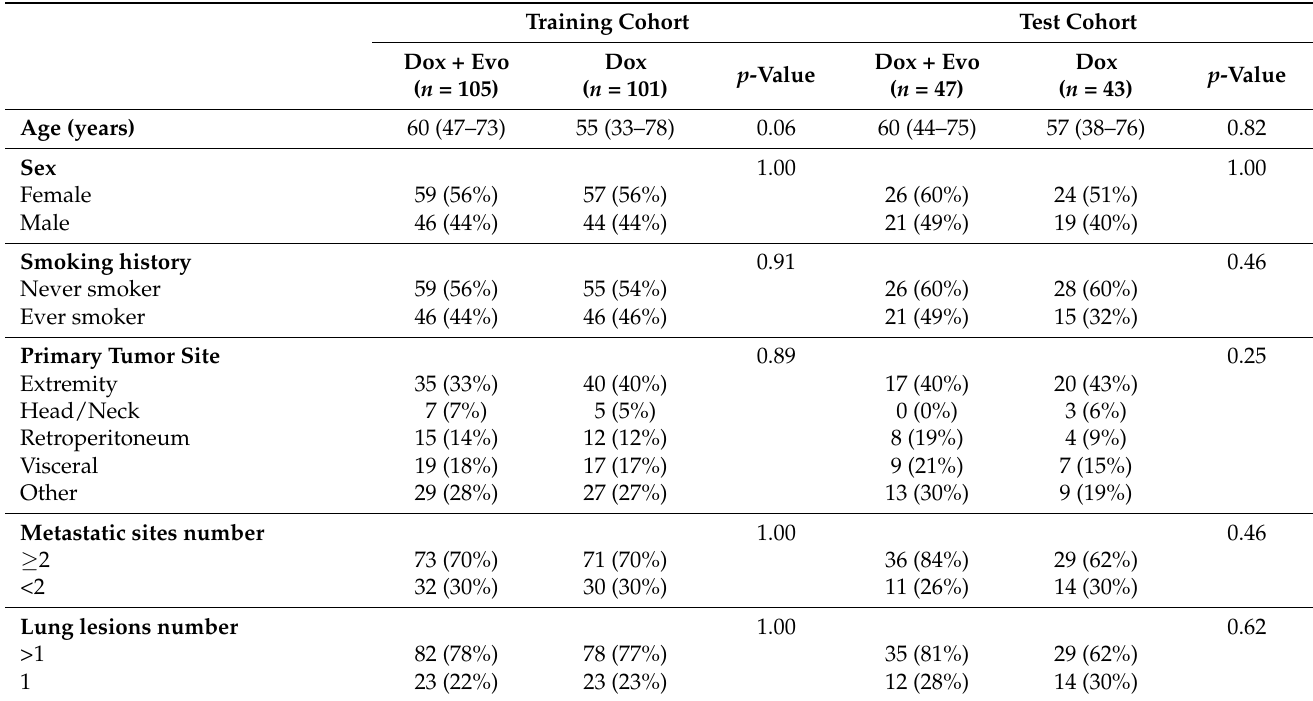
Table 1. Breakdown of patient characteristics. Numbers are presented for each treatment group in training and test cohort. Data are median (IQR) or n (%). P value by Wilcoxon test (for age) or Chi squared test (all other